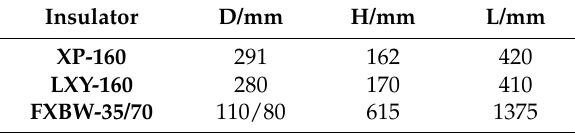
Figure 2. Structural diagram of the specimen. ( a ) XP-160; ( b ) LXY-160; ( c ) FXBW-35/70. Table 1. Main structural parameters of the specimen.